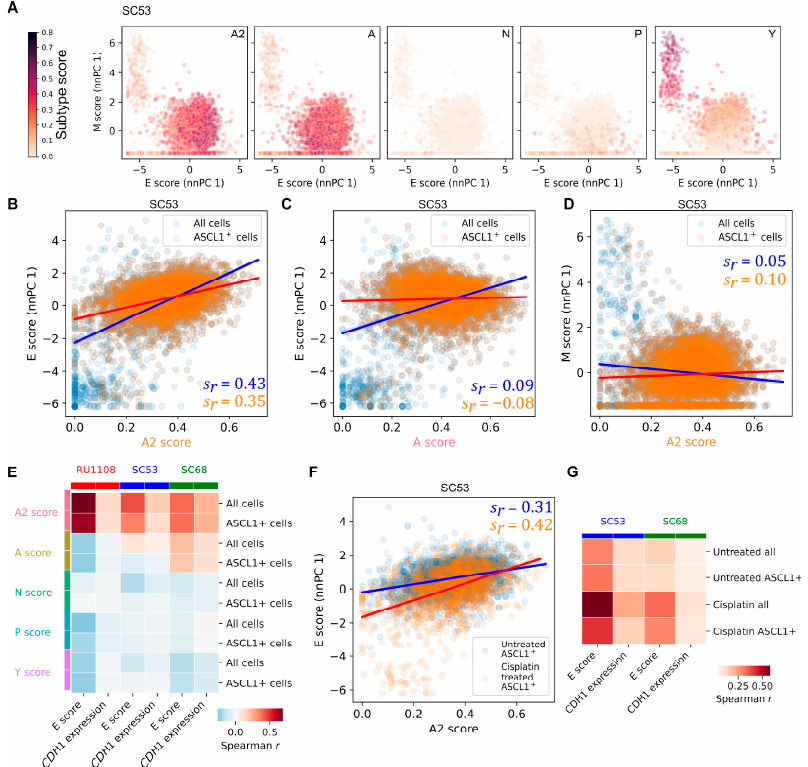
Figure 4. Correlations between A2 and epithelial transcriptional programs in individual human tumor cells. ( A ) A total of 5268 single-cell transcriptomes from SCLC tumor SC53 [9] were projected onto the E and M score axes using nnPCA. Colors indicate SCLC subtype scores (see Section 2). ( B – D ) Linear regression lines and confidence intervals were obtained for all cells and ASCL1 + cells from data in D. ( E ) Datasets of three tumors (top labels) were used to compute the Spearman correlation coefficients between SCLC subtype scores (left labels) and E scores from nnPCA or CDH1 expression levels. All cells and ASCL1 + cells were analyzed separately. ( F ) Correlations between A2 scores and E scores (nnPCA) in untreated and cisplatin-treated cells of SC53 tumor. ( G ) Datasets of SC53 and SC68 tumors were used to compute the Spearman correlation coefficients between SCLC subtype scores (left labels) and E scores from nnPCA or CDH1 expression levels. All cells and ASCL1 + cells were analyzed separately. Untreated and cisplatin-treated cells were analyzed separately.